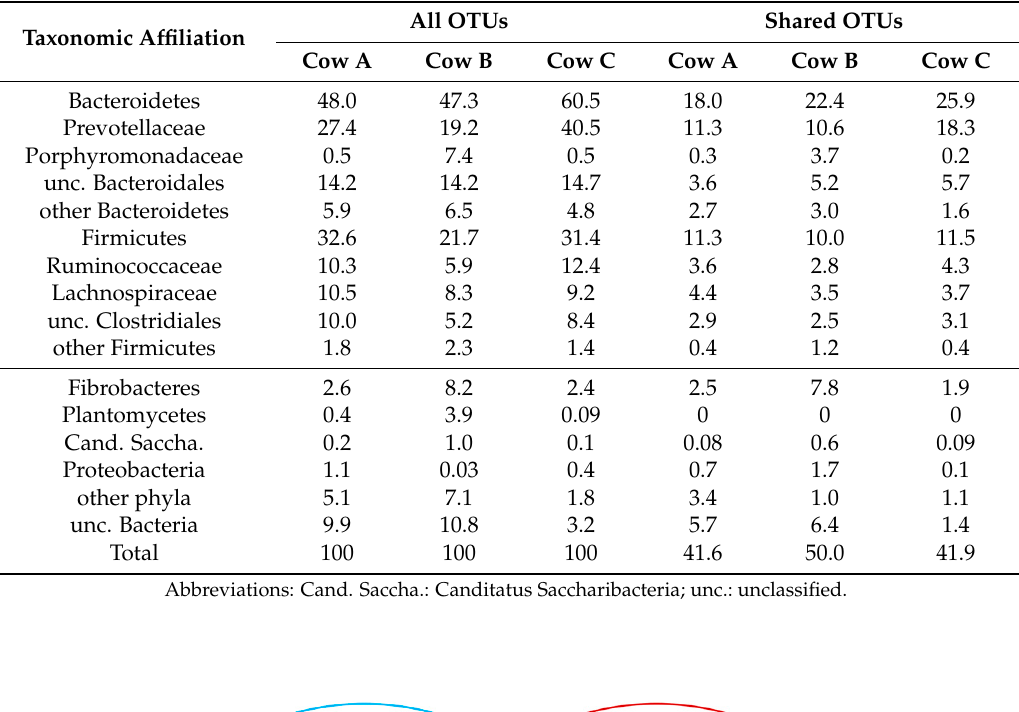
Table 1. Taxonomic profile of rumen bacteria from three beef cows on a forage-based diet. For each sample, relative abundances (%) are shown for all Operational Taxonomic Units (OTUs) as well as for the 252 OTUs shared among animals. Phyla are highlighted in bold, with most highly represented lower taxa shown for Bacteroidetes and Firmicutes.